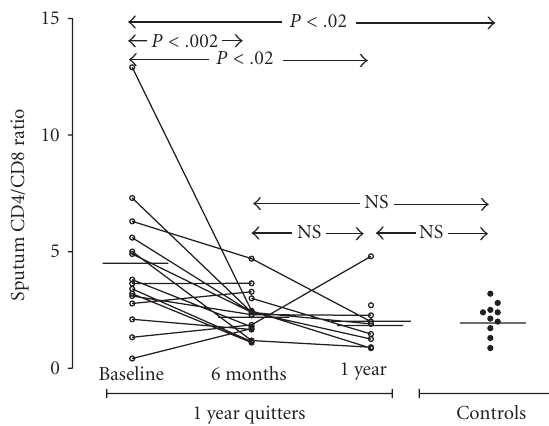
Figure 5: Percentage of sputum CD4 + /CD8 + T-cells (% sputum lymphocytes) in “healthy” smokers before smoking cessation ( n = 16), after 6 months of smoking cessation ( n = 18), and after 1 year of smoking cessation ( n = 9). Results from 10 controls are also